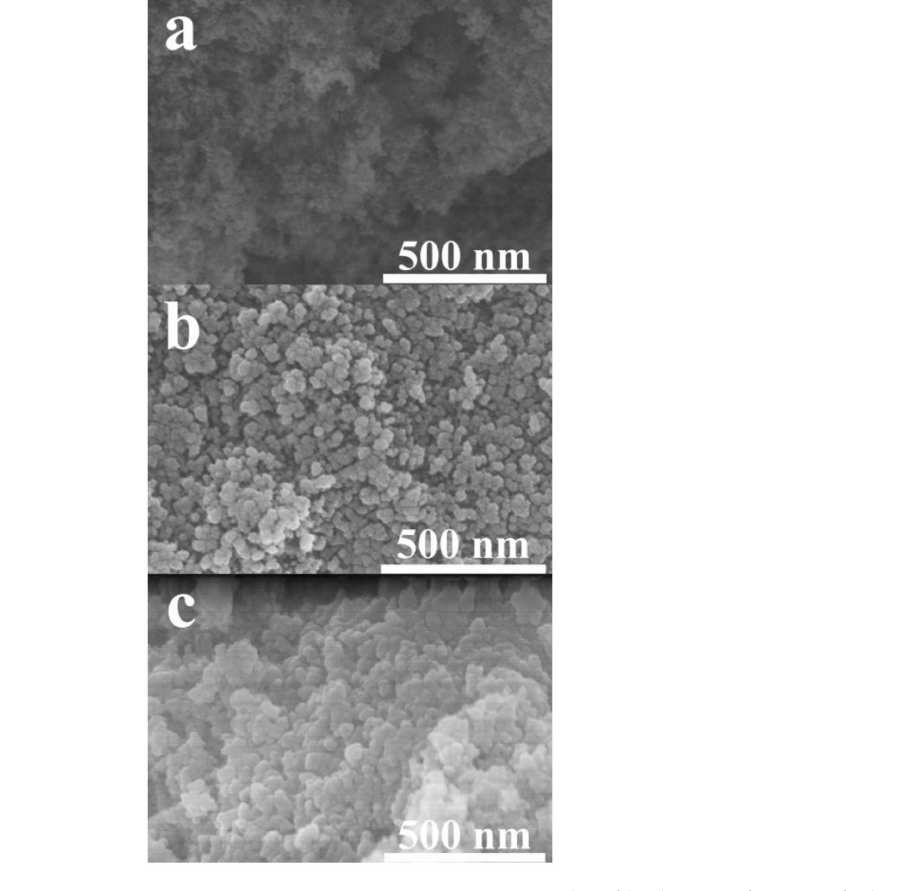
Figure 5. Cross-section FESEM micrographs of high magnification of silica aerogel porous struc- ture as ( a ) pristine silica aerogel, ( b ) silica aerogel in 40 phr composite, and ( c ) silica aerogel in 60 phr